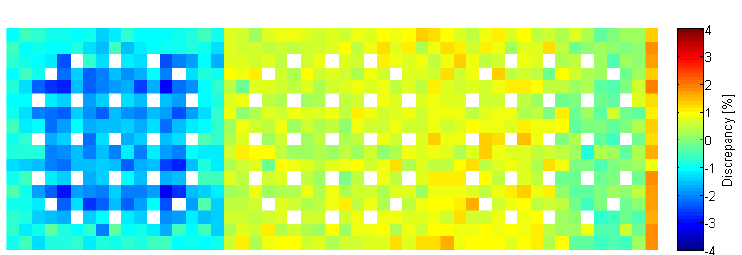
Figure 8. Pin power errors in axial layer between 100 and 100.5 cm from the bottom.